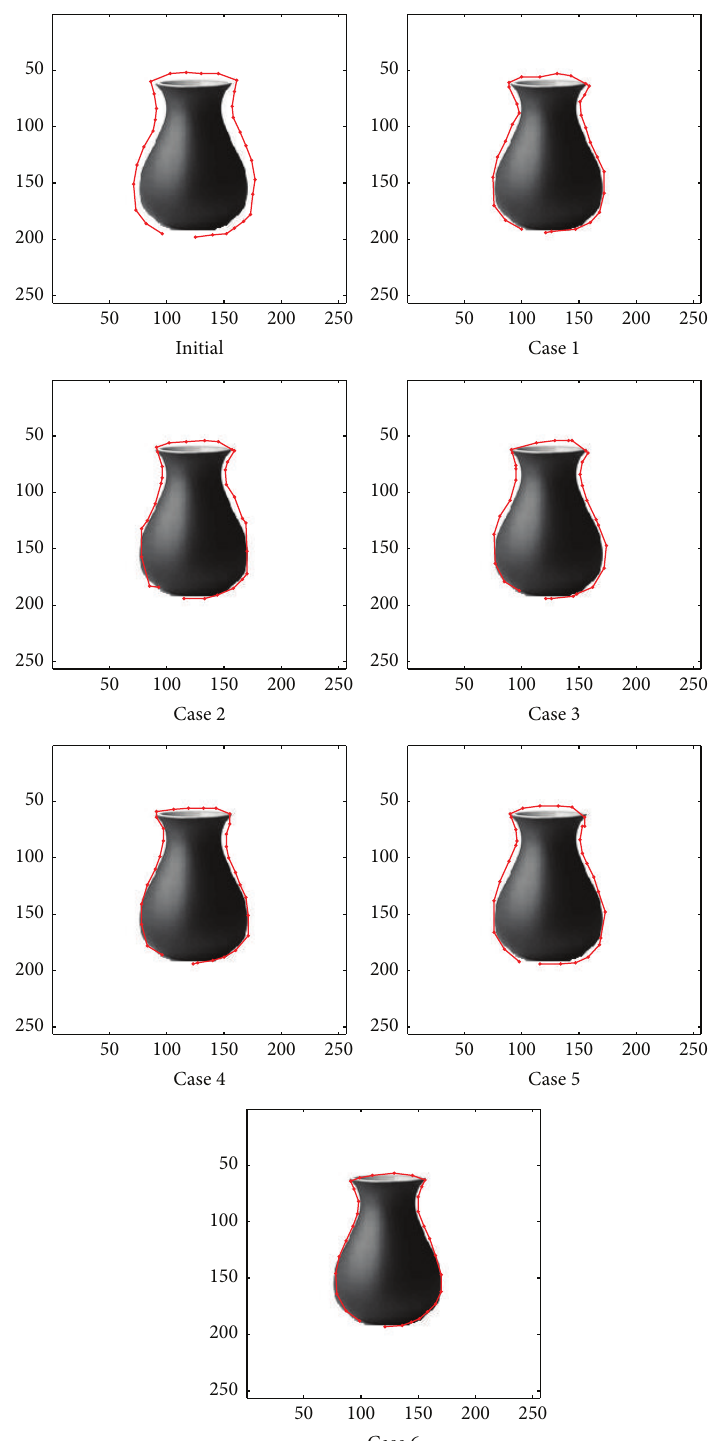
Figure 17: Active contour model implementation by “proposed multiswarm PSO” method for different cases of inertia. Results for “Vase” image with control points = 30, 𝛼 = 0.321 , 𝛽 = 0.054 , and Γ = 0.003